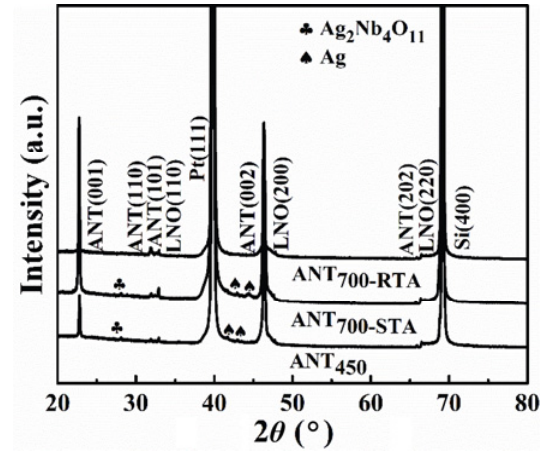
Fig. 1 XRD patterns of ANT 450 , ANT 700-STA , and ANT 700-RTA